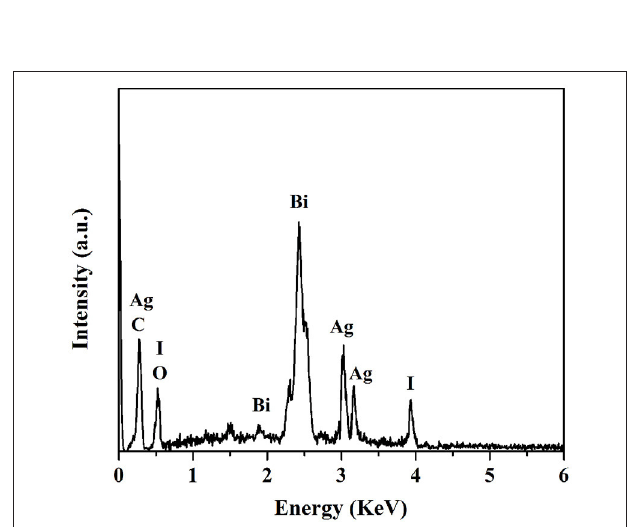
FIGURE 3 | EDS spectra of